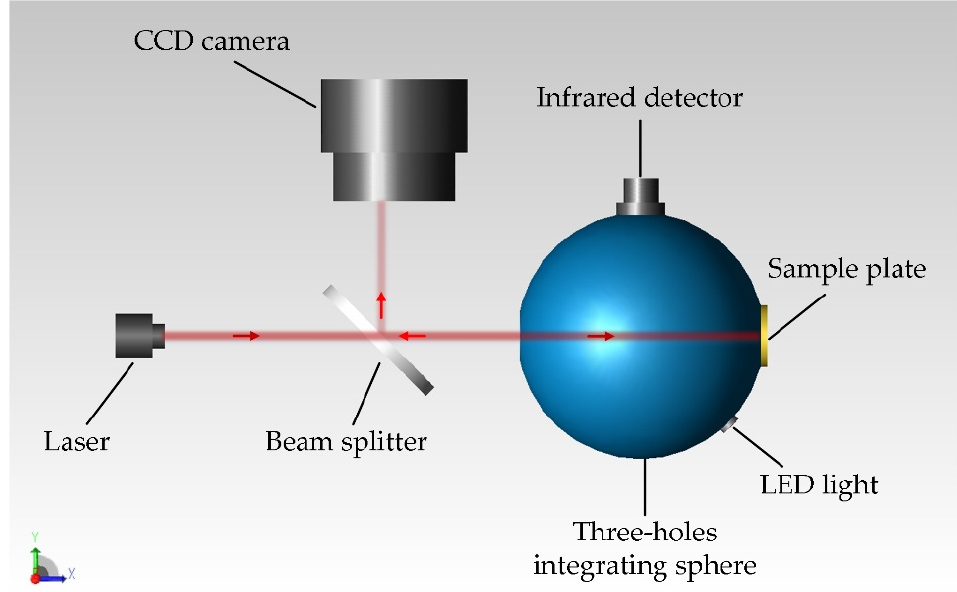
Figure 8. Diagram of high-precision surface-scattering measurement system model. Before using the high-precision integrating-sphere scattering-rate system for measure- ment, the aiming-and-positioning system should be firstly used to aim at the measuring region. When aiming, one can observe the spot position on the sample plate through the image collected by CCD camera, and then adjust the laser incident position according to the image to make the spot coincide with the region interested. Before the reflectivity measurements, the laser incident angle and the horizontal and vertical offset positons are adjusted by using the three-dimensional displacement adjustment platform and collimator to ensure that the incident laser beam vertically passes through the integrating sphere from the center of the incident beam opening to the center of the sample opening. Once the laser incidence angle is adjusted, the position of the laser spot relative to the sample opening remains unchanged, and then the relative position of the sample plate is adjusted by using the three-dimensional displacement platform to select the region to be measured. After the region to be measured has been selected, the laser at 1064 nm should be turned on to record the luminous flux received by the infrared detector. According to the cali- bration relationship between the simulated luminous flux and detector photocurrent, the scattering rate for the specific region on the sample surface to the corresponding laser wavelength can be calculated. The photograph of high-precision three-hole-integrating- sphere coating-scattering-rate measurement system is shown in Figure 9. The specific technical parameters of the system are shown in Table 1. The flowchart of high-precision scattering-rate measuring system is shown in Figure